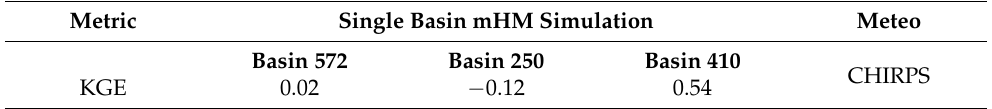
Table 5. mHM validation results on independent